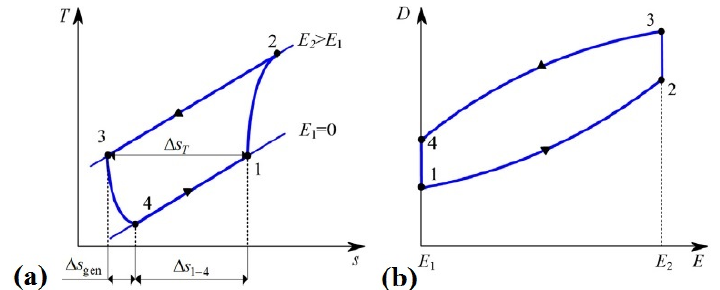
Figure 6. Active electrocaloric regenerative (AER) thermodynamical cycle, property of a hysteretic material, on ( a ) T-s; ( b ) D-E diagram [29].